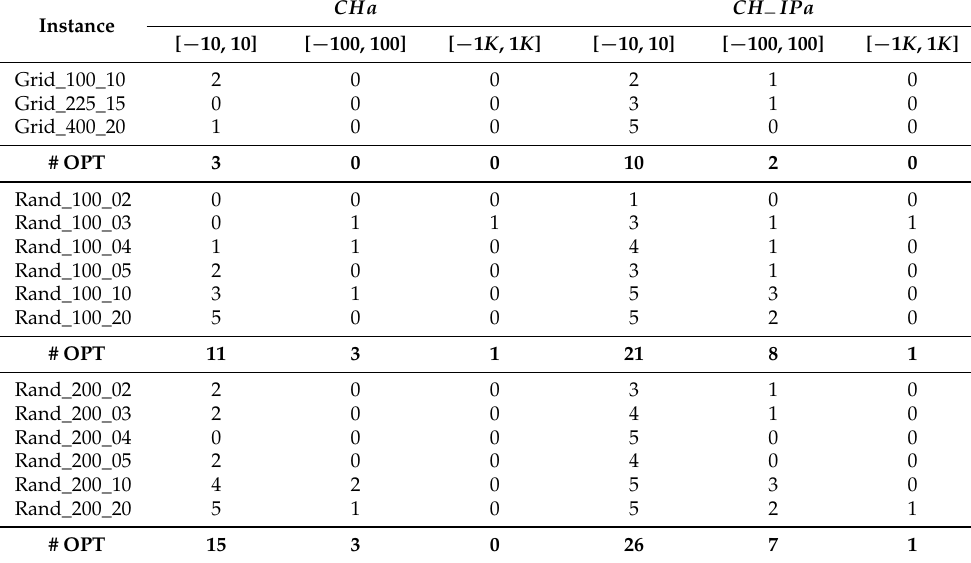
Table 1. Number of optimal solutions identified—instances with random costs.